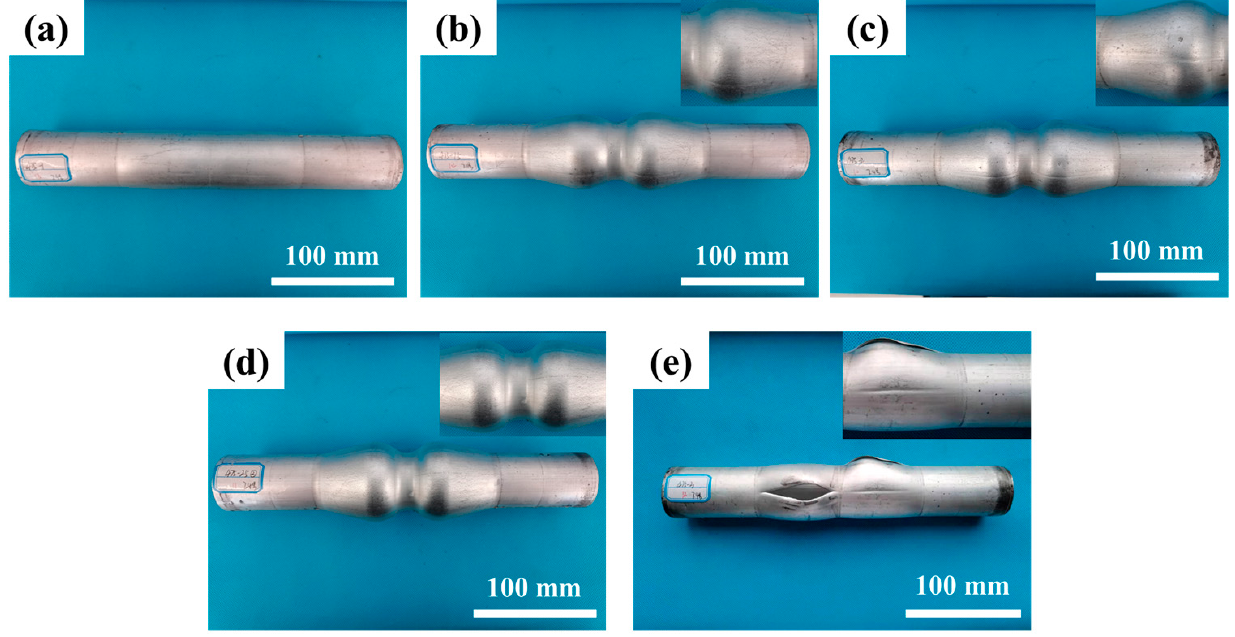
Figure 6. Forming results of parts under different forming pressures at 475 °C: ( a ) 1 MPa; ( b ) 1.5 MPa; ( c ) 2 MPa; ( d ) 2.5 MPa; ( e ) 3 MPa.